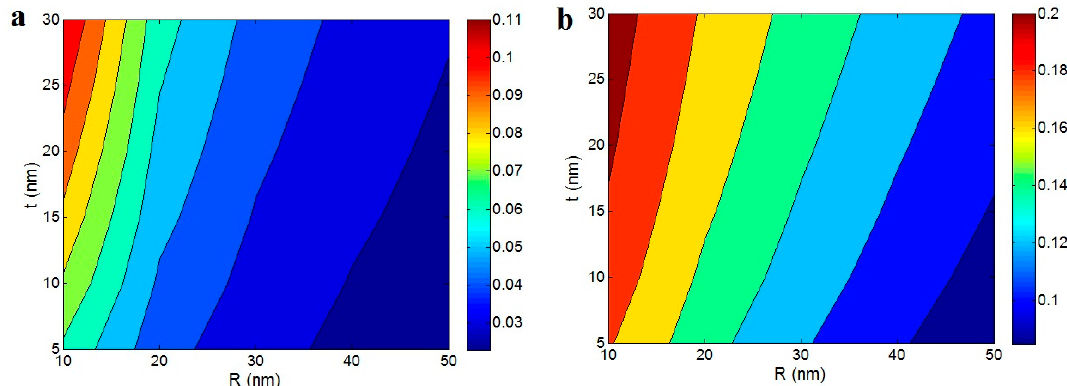
Figure 6. The roles of “ R ” and “ t ” parameters in the fraction of percolating network in the nanocomposites ( f ) according to ( a ) Equation (12) and ( b ) Equation (13) at φ f = 0.02, l = 5000 nm and A = 0.02.